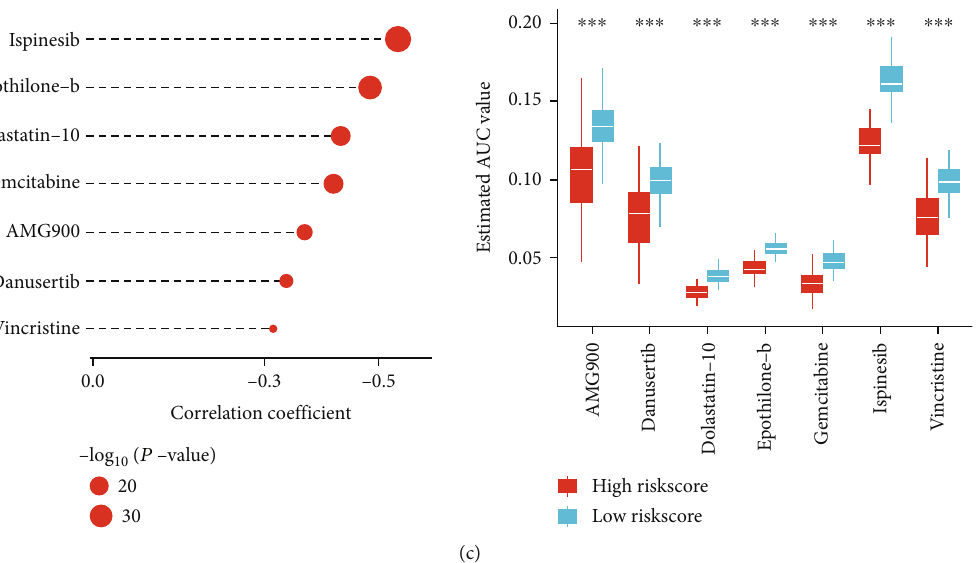
Figure 8: Clinical therapeutic bene fi t of the cuproptosis-relevant lncRNA signature for chemotherapy and small molecule compounds. (a) Boxplots displaying the estimated clinical chemotherapeutic sensitivity in low- and high-risk subsets. (b) Correlations of risk score with AUC values of CTRP-derived small molecule compounds (left) and comparison of AUC values between low- and high-risk subsets (right). (c) Associations of risk score with AUC values of PRISM-derived small molecule compounds (left) and comparison of AUC values between low- and high-risk subsets (right). ∗∗ p < 0 : 01 ; ∗∗∗ p < 0 : 001